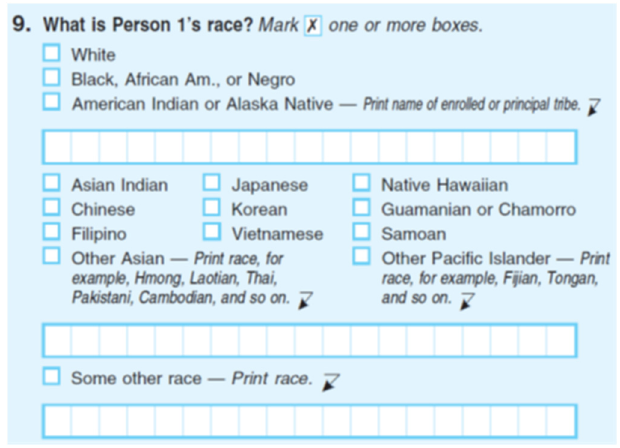
Figure 2. Race question, as written in the 2010 U.S. Census.